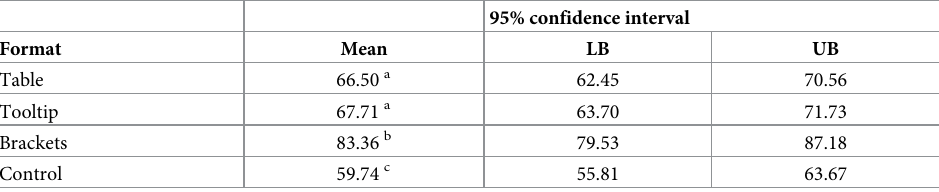
Table 5. Mean percentage of best estimates that agree with the ICD 203 standard by presentation format.